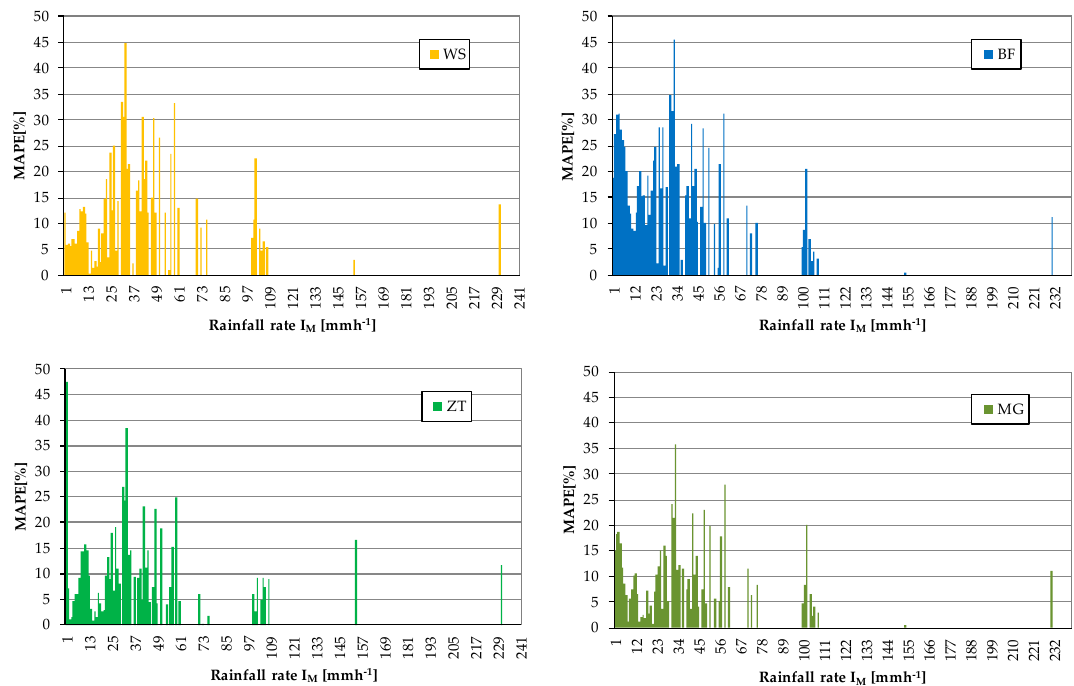
Figure 15. Value of mean absolute percentage error (MAPE) between KE mm(E) and Wischmeier and Smith (WS), Brown and Foster (BF), Zanchi and Torri (ZT), and McGregor et al. (MG), clockwise.